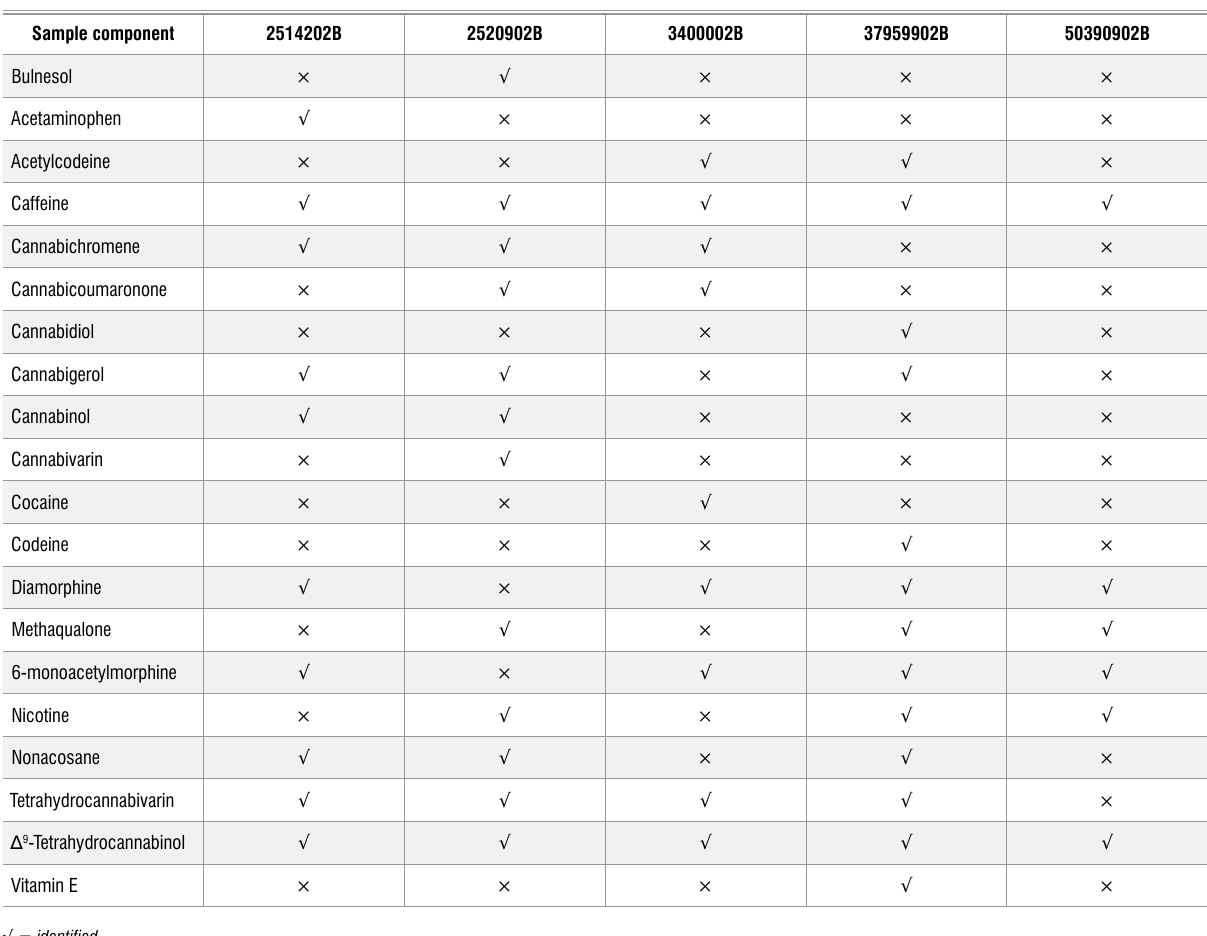
Table 4: Components identified in the five casework samples Sample component